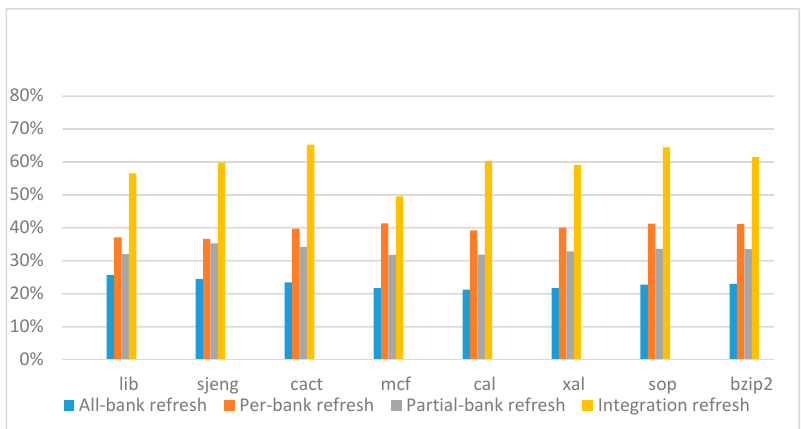
Figure 26. Energy reduction normalized to 1x granularity baseline (tRFC = 890 ns, weak row = 1%).